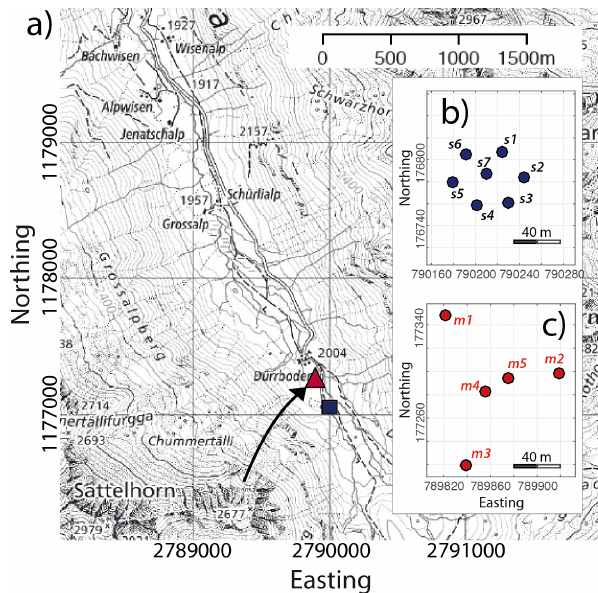
Figure 1. Map (a) showing the location of the Dischma valley, south of Davos, Switzerland. The location of the infrasound array (red triangle) and the seismic array (blue square) are shown, as well as the Chlein Sattelhorn avalanche path (black arrow). Positions are given in Swiss coordinates (CH1903). Reproduced with permission of swisstopo (JA100118). Details of the geometry of the seismic (b) and infrasound arrays (c)